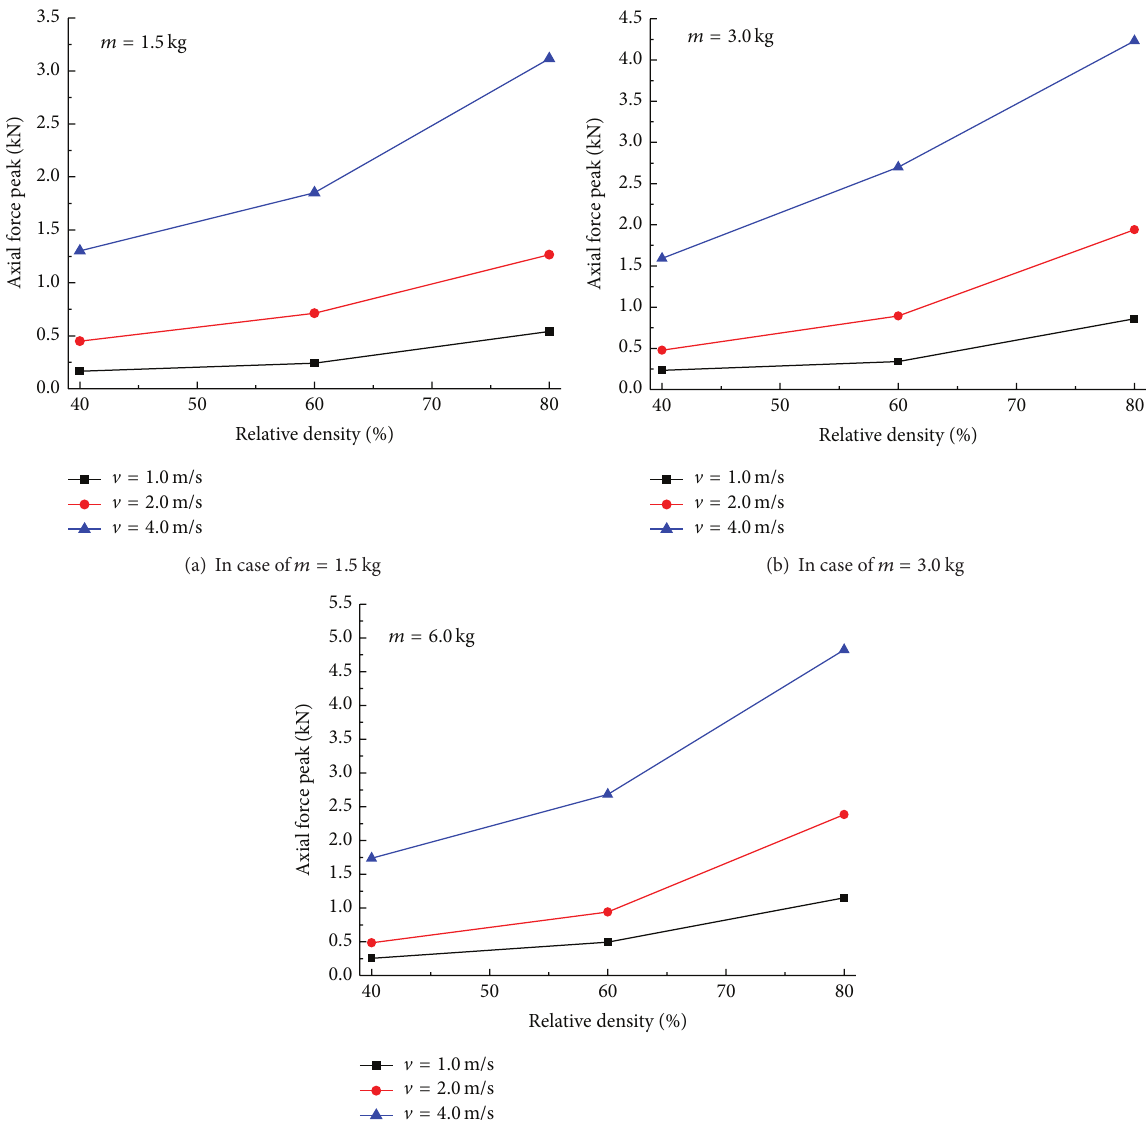
Figure 16: Effect of relative density on peak axial